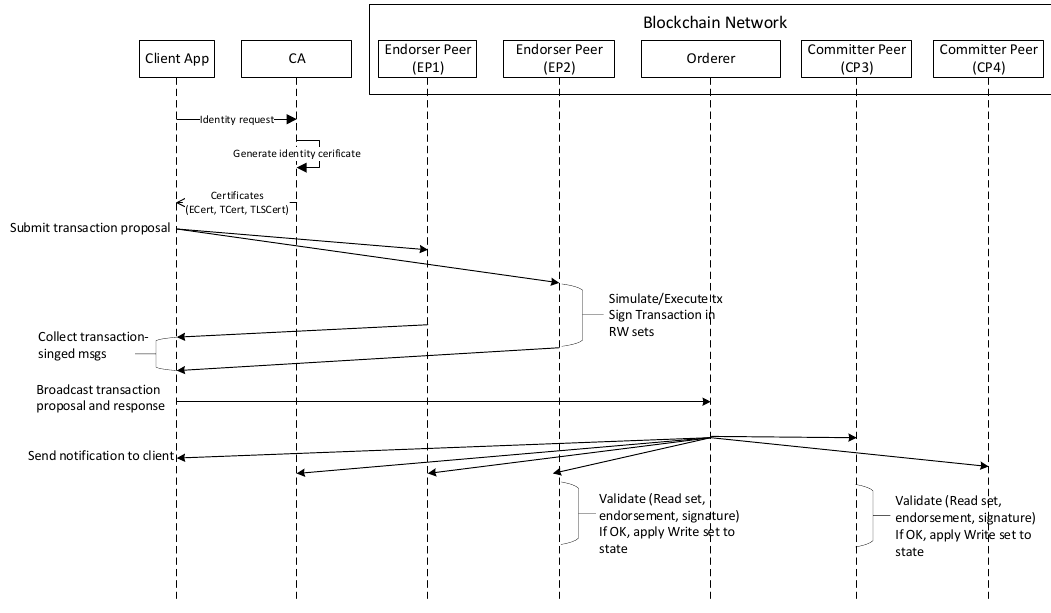
Figure 7. Transaction operational processes in the blockchain network.